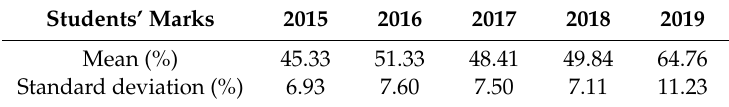
Table 3. Statistical results of students’ marks after using VRLE one year prior.